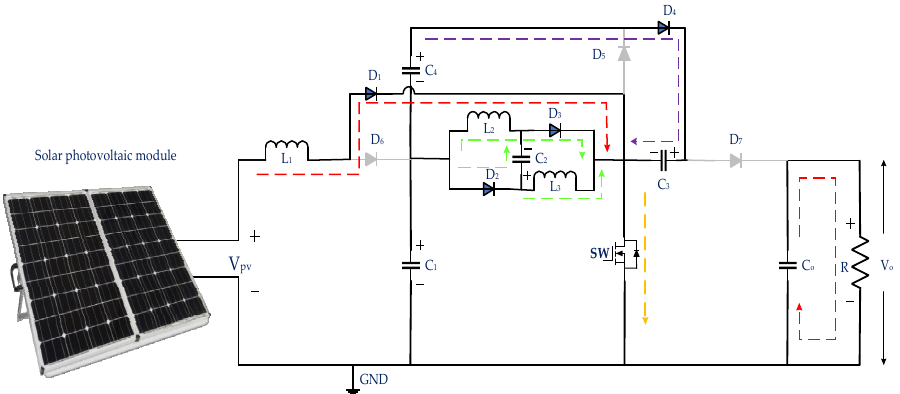
Figure 7. Operation of proposed HVGSU converter configuration during mode 1.